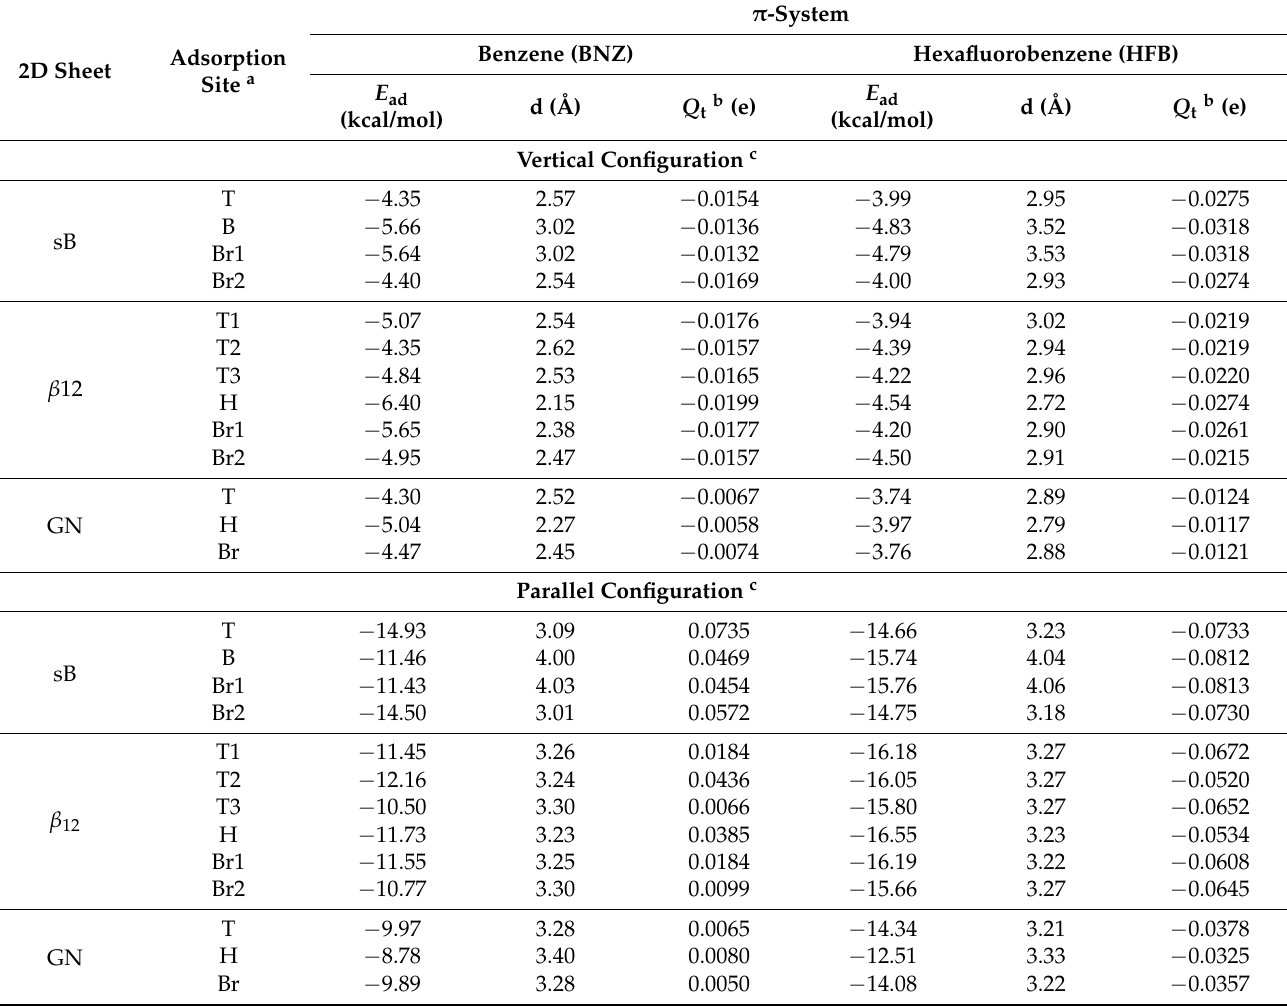
Table 1. Adsorption energies ( E ad , kcal/mol) and equilibrium distances (d, Å) of the relaxed structures of BNZ and HFB on the sB, β 12 , and GN sheets in the vertical and parallel configurations at all studied adsorption sites, as well as the charge transfer difference ( Q t , e) for the 2D sheets before and after the adsorption